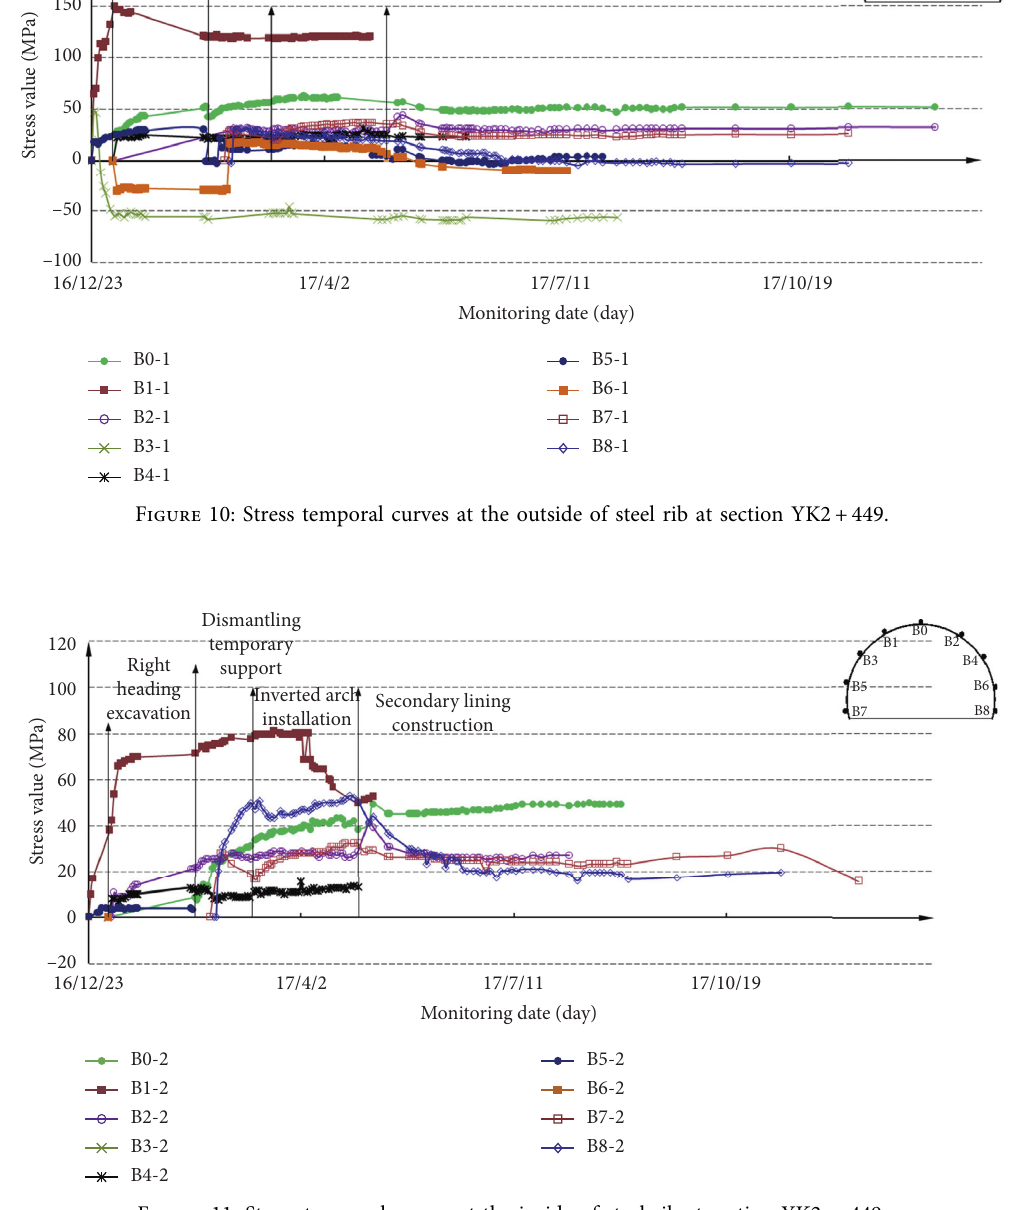
Figure 11: Stress temporal curves at the inside of steel rib at section YK2 +